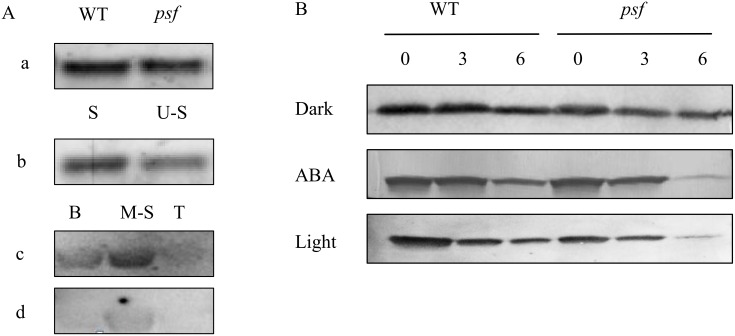
Changes in D1 protein abundance detected by Western blotting for the un-detached and detached leaves of different treatments.(A) Effects of shaded treatments on the D1 protein abundance detected by Western blotting. (A(a)) D1 protein amount in flag leaves of Fig 4A(a) and 4A(b). (A(b)) D1 protein amount in different leaf segments of Fig 4A(c), S: indicates shaded area, U-S: indicates un-shaded area. (A(c)) D1 protein amount in different leaf segments of Fig 4A(d), B: indicates base un-shaded area, M-S: indicates middle shaded area, T: indicates tips un-shaded area. (A(d)) D1 protein amount in different leaf segments of Fig 4A(e). (B) Effects of ABA, dark and light treatments on the D1 protein abundance detected by Western blotting in detached leaf segments of wild type and psf mutant. 0, 3 and 6 indicate days after incubation.